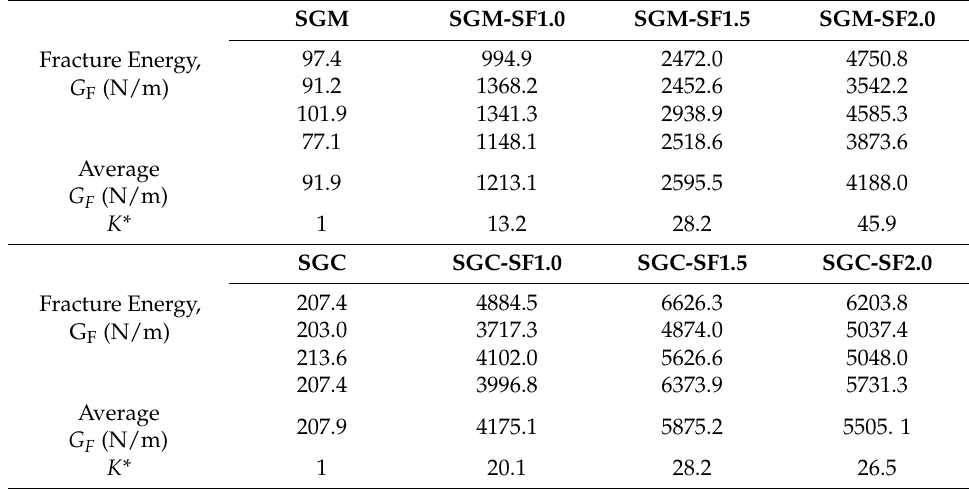
Table 5. Fracture energy of plain and steel fiber-reinforced SGM/SGC.